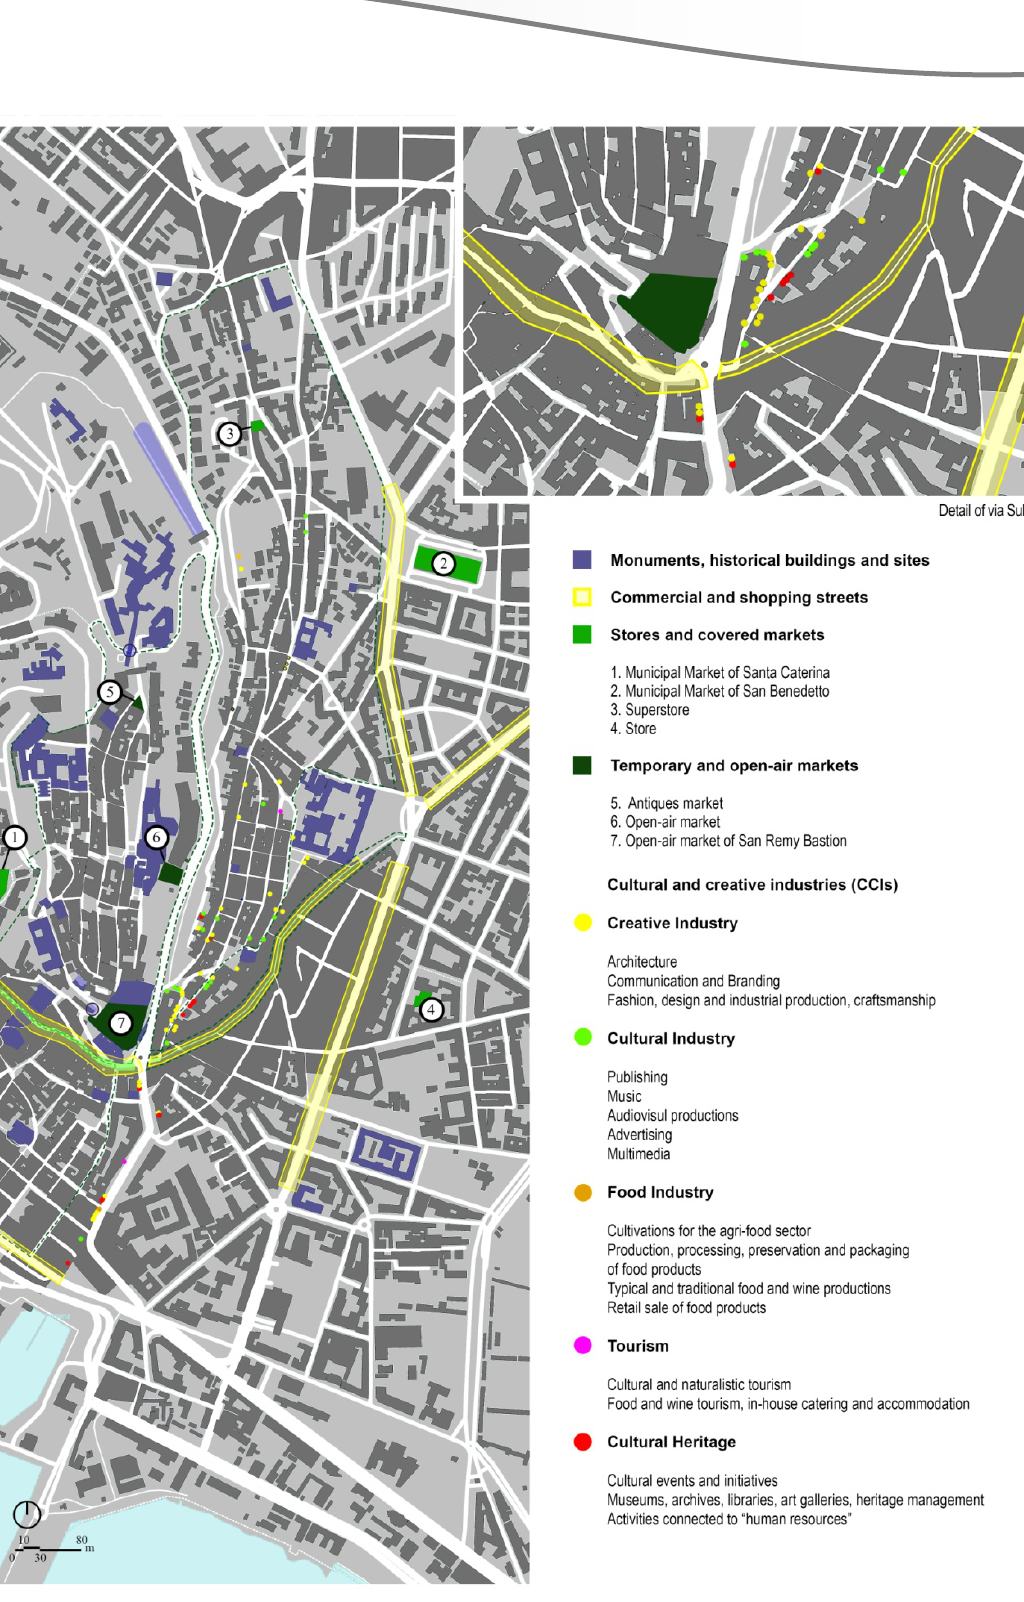
Figure 3: Map of creative enterprises as of 2015, based on data taken from the Company Register of the Chamber of Commerce of